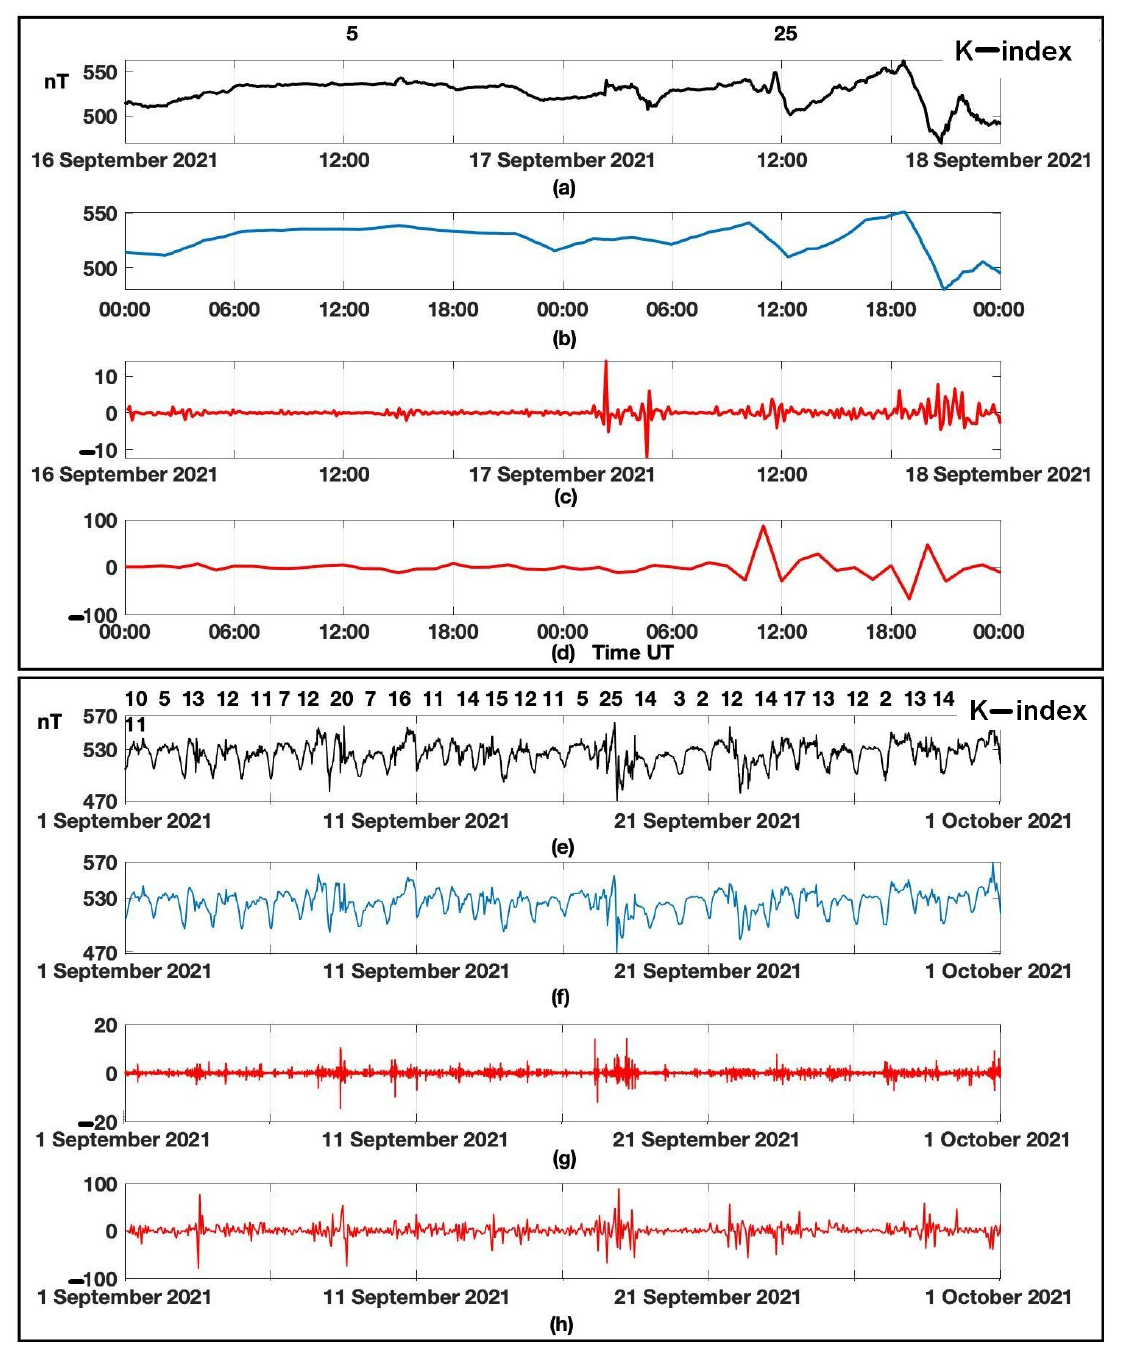
Figure 1. Application of MSA to Paratunka observatory data applying the Daubechies 3 wavelet. ( a , e ) H-component; ( b , f ) f j − 6 component; ( c , g ) g j − 3 component; ( d , h ) g j − 6